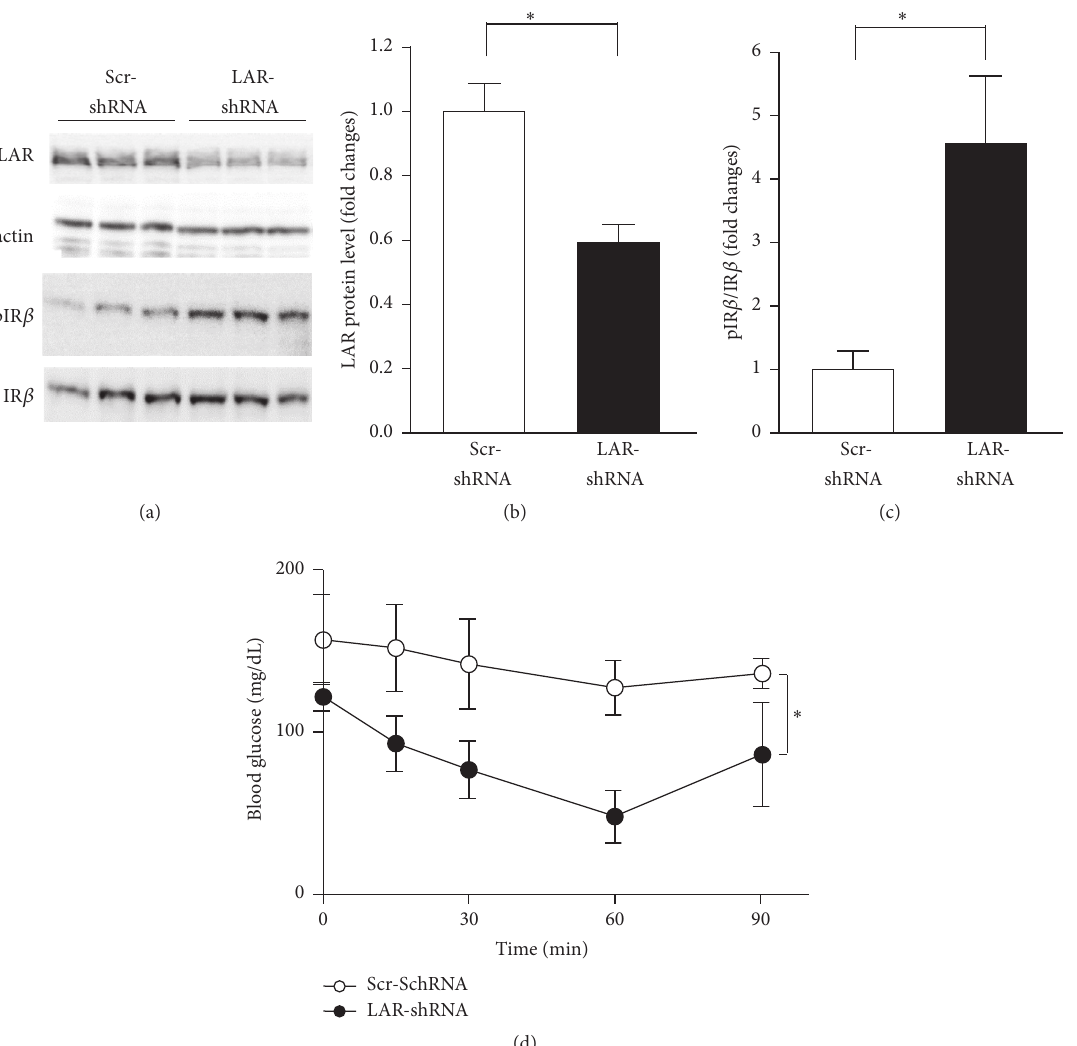
Figure 4: Effects of LAR knockdown on insulin sensitivity in liver of wild type mice fed HFD. (a) Western blot analysis using anti-LAR and anti-phospho-insulin receptor 𝛽 -subunit (pIR 𝛽 ) in the liver of HFD mice at 1 week after injection of AAV-Scr-shRNA or LAR-shRNA. Liver samples were collected at 10min after insulin injection (0.5IU/kg). (b) LAR protein levels, relative to 𝛽 -actin (actin), in the liver. 𝑛 = 3 for each group. (c) The intensity of IR 𝛽 phosphorylation is expressed by the ratio of phosphorylated over total insulin receptor 𝛽 -subunit (IR 𝛽 ) proteins. (d) Blood glucose levels in ITT in HFD mice at 1 week after injection of AAV-Scr-shRNA or LAR-shRNA. Insulin at 0.5 IU/kg body weight was injected to mice fasted for 6 h. All data are presented as means ± s.e.m. ∗ 𝑝 < 0.05